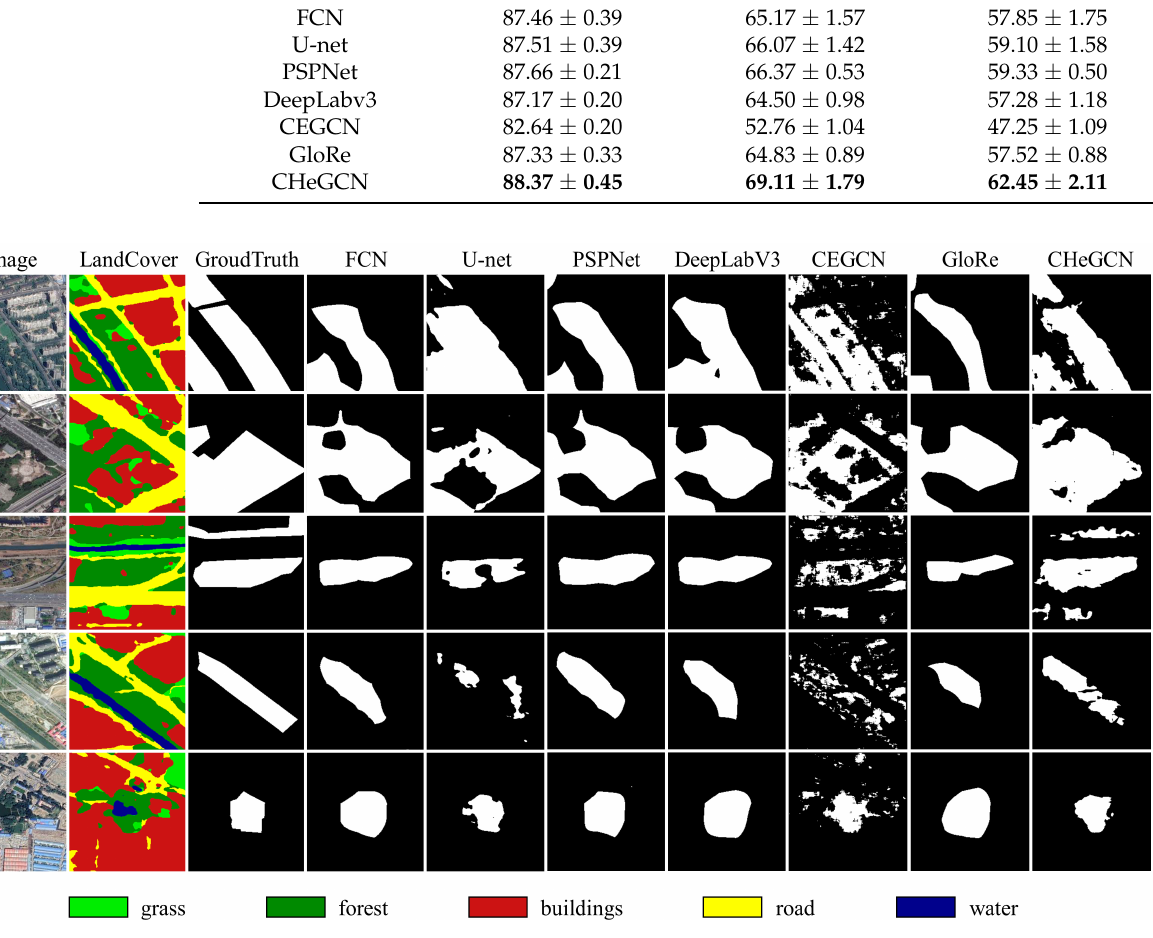
Figure 6. Qualitative segmentation results of different methods. Five examples are provided for comparison of models. The first column is the images, the second one indicates the land cover data, the third one lists the corresponding ground truth, and the following columns exhibit the segmentation results of different models. The color table for land cover categories is listed at the